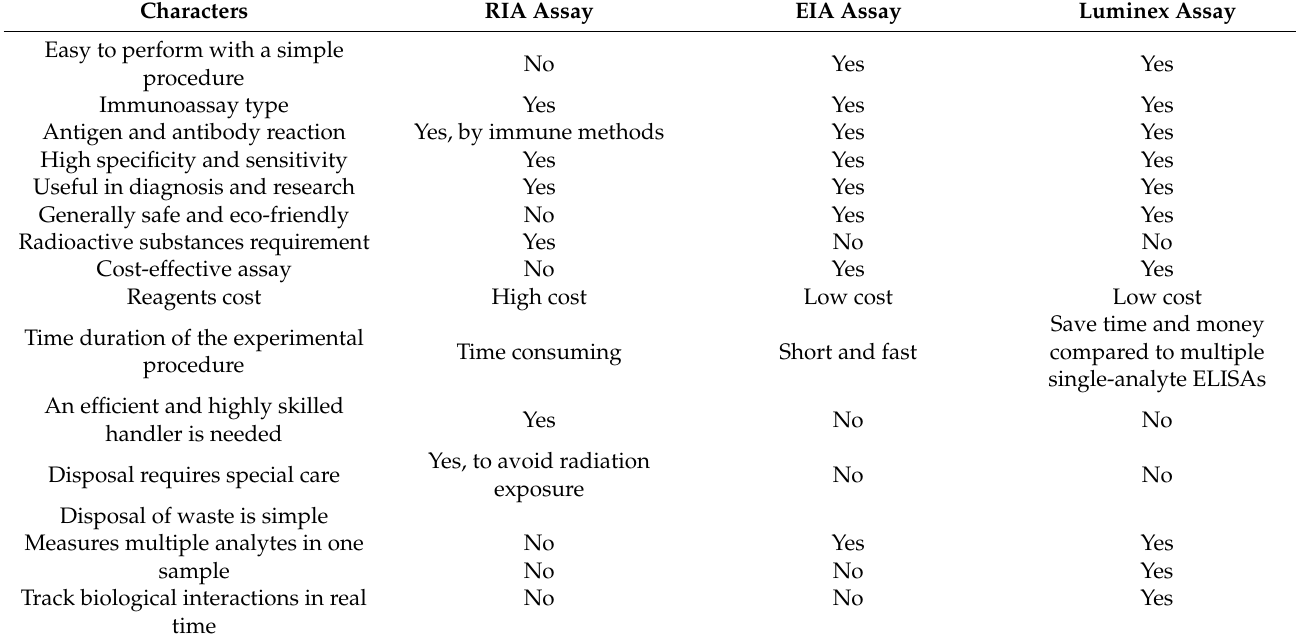
Table 3. Comparison of (radio-immunoassay) RIA, (enzyme immunoassays) EIA assay and Luminex 1 methods of hormone